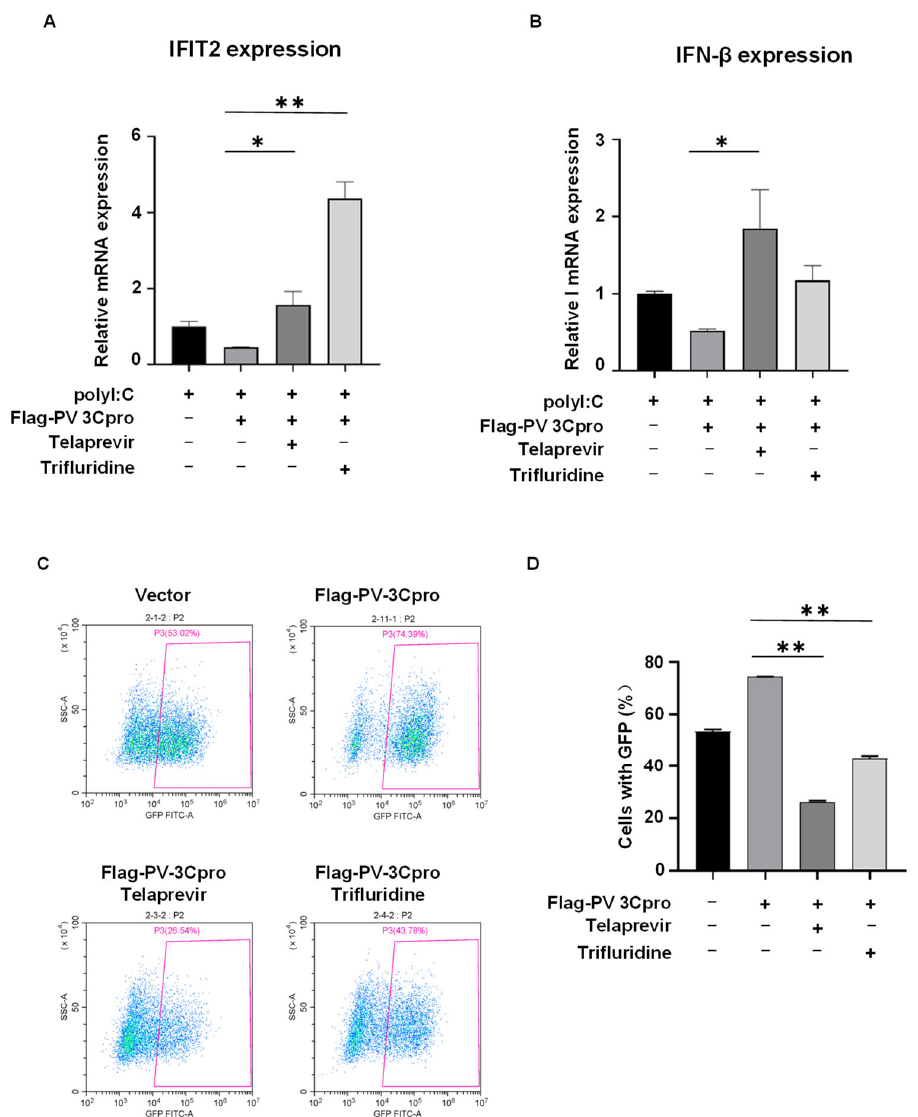
Figure 6. Telaprevir and Trifluridine counteract PV 3Cpro-mediated inhibition of innate immune response and facilitation of viral replication. ( A , B ) 293T cells were transfected with Flag-PV 3Cpro or vectors, and were untreated or treated with 10 µ M Telaprevir and Trifluridine 5 h after transfection. A period of 22 h later, cells were transfected with polyI:C for 9 h and then harvested for RNA extraction and qPCR for IFIT2 ( A ) and IFN- β ( B ). Quantitative data are expressed as the means ± SD; n = 3. Statistics: Student’s t -test (*, p < 0.05, **, p < 0.01). ( C ) 293T cells were transfected with Flag-